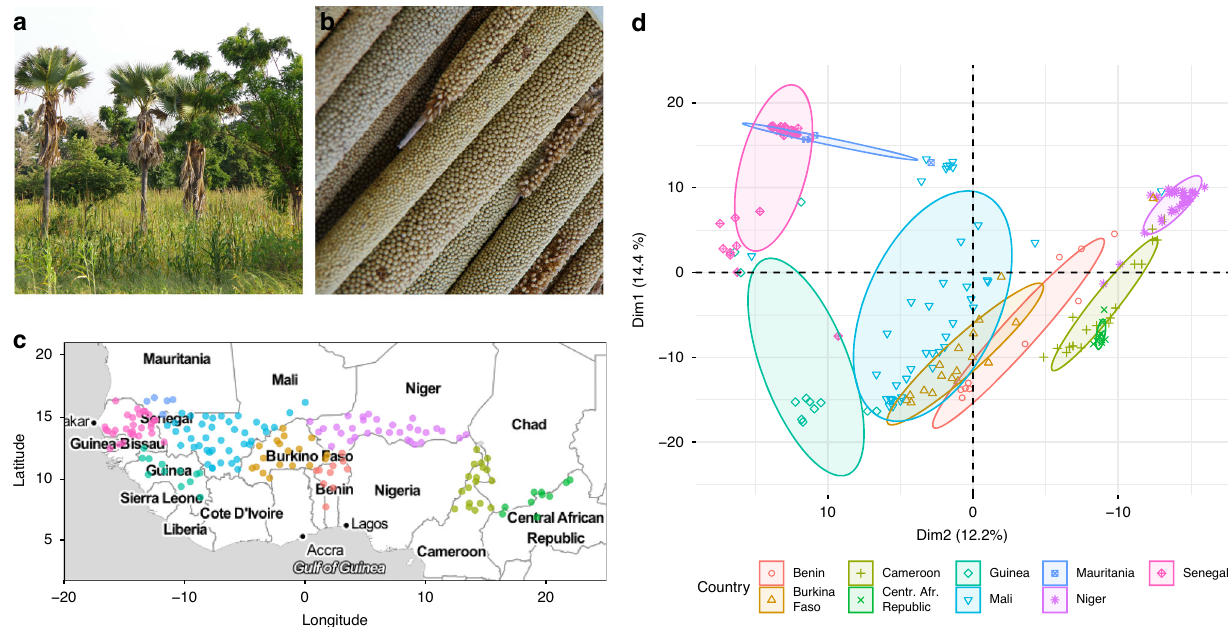
Fig. 1 Diversity of pearl millet varieties in West Africa. a Photo of a pearl millet fi eld in Senegal ©A. Barnaud, IRD. b Early- fl owering pearl millet panicle from Senegal, © C. Berthouly-Salazar, IRD. c Map of the 173 accessions of pearl millet considered in this study. d Principal component analysis (PCA) of pearl millet landraces based on SNP allele frequencies. The plot shows landrace PCA projections on the fi rst two axes that explain 26.6% of total variance. Landraces are colored according to the country. Concentration ellipses with a normal probability of 0.6 are drawn around landraces originating from the same country.